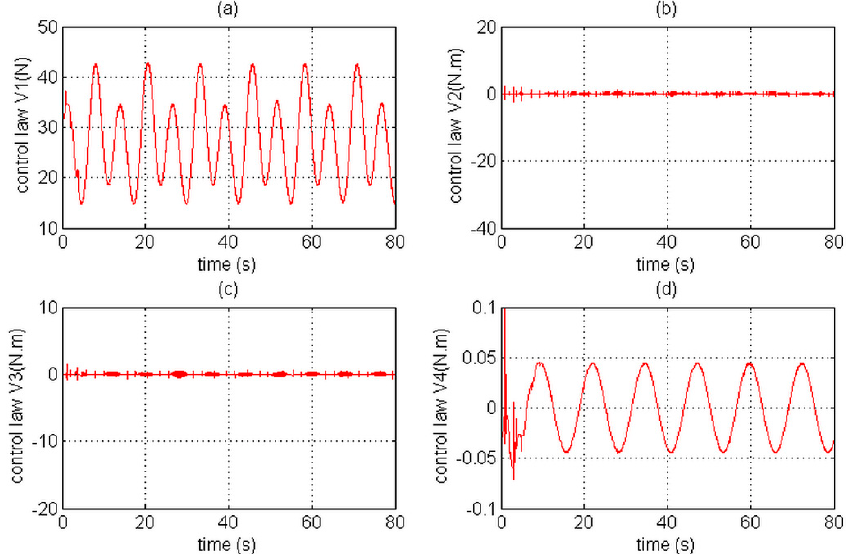
Figure 28. The applied control laws of the CMTC: ( a ) control law 1 V (N); ( b ) control law 2 V (N·m); ( c ) control law 3 V (N·m); ( d ) control law 4 V (N·m).